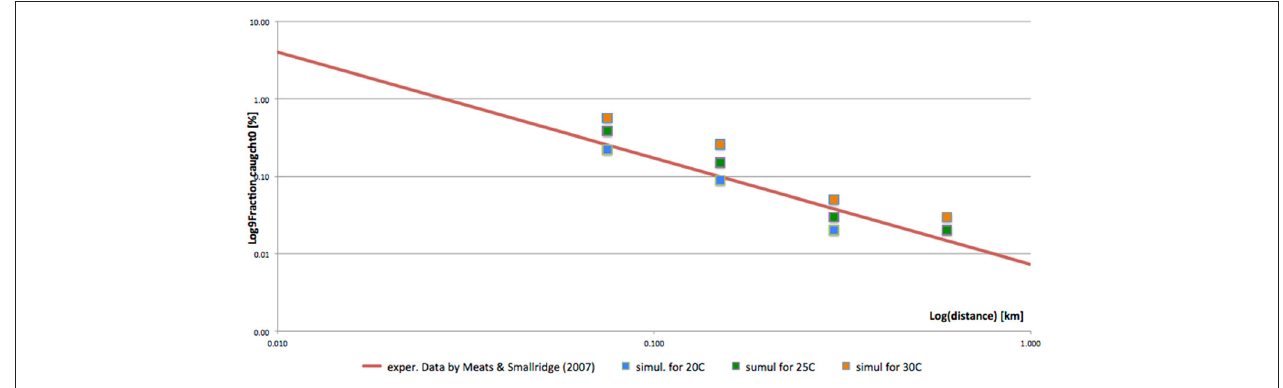
FIGURE 4 | Effects of trap distance on number of females